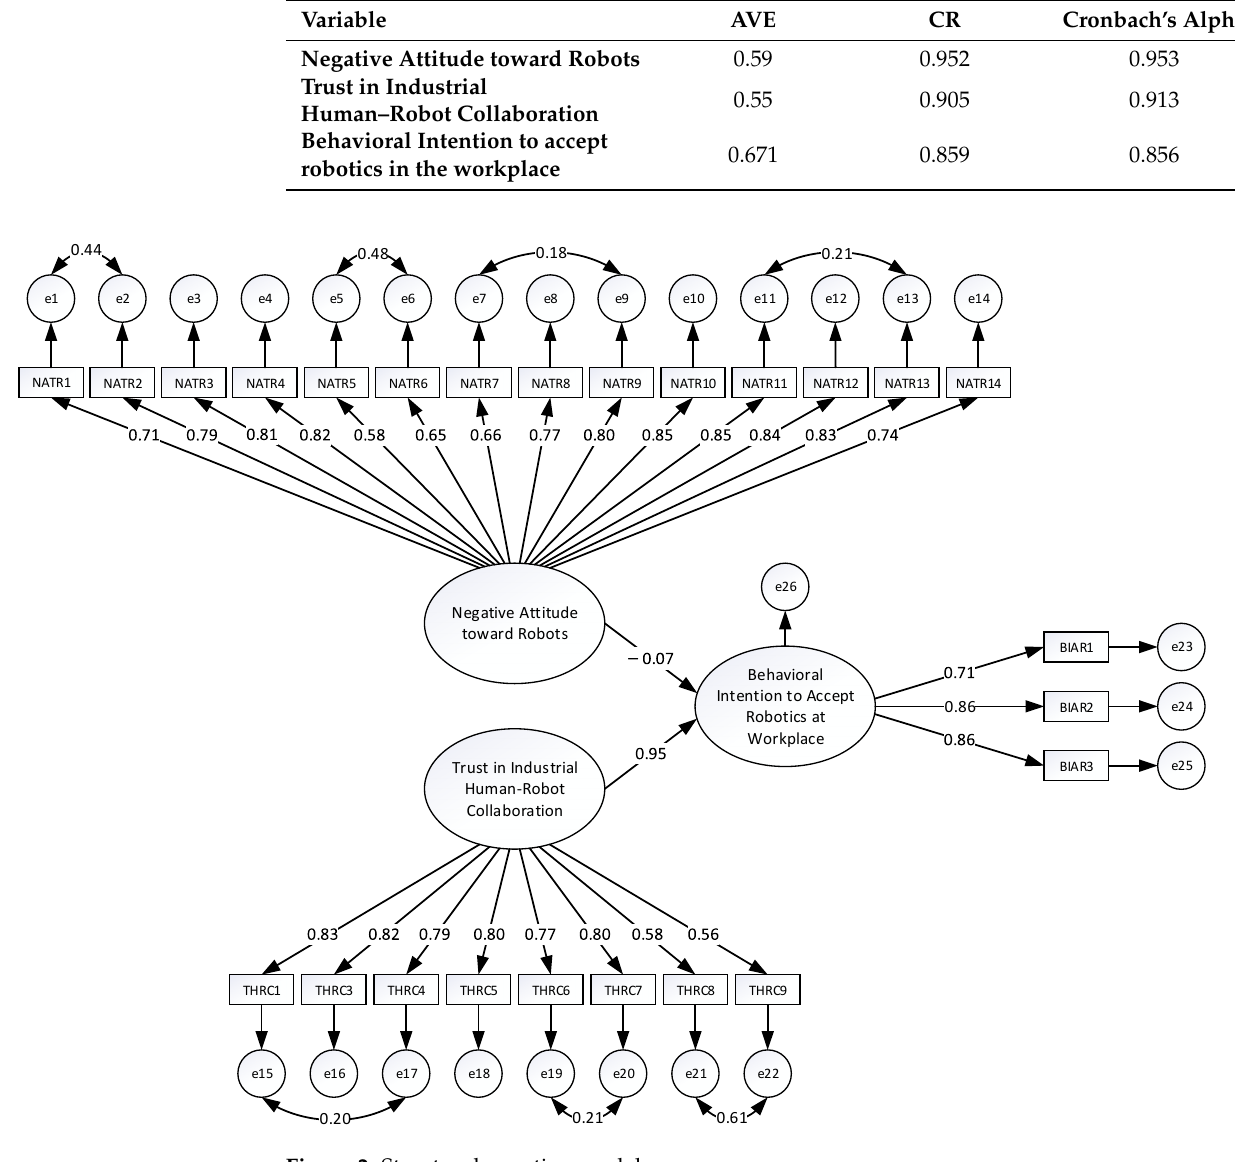
Table 4. Validity and Reliability.